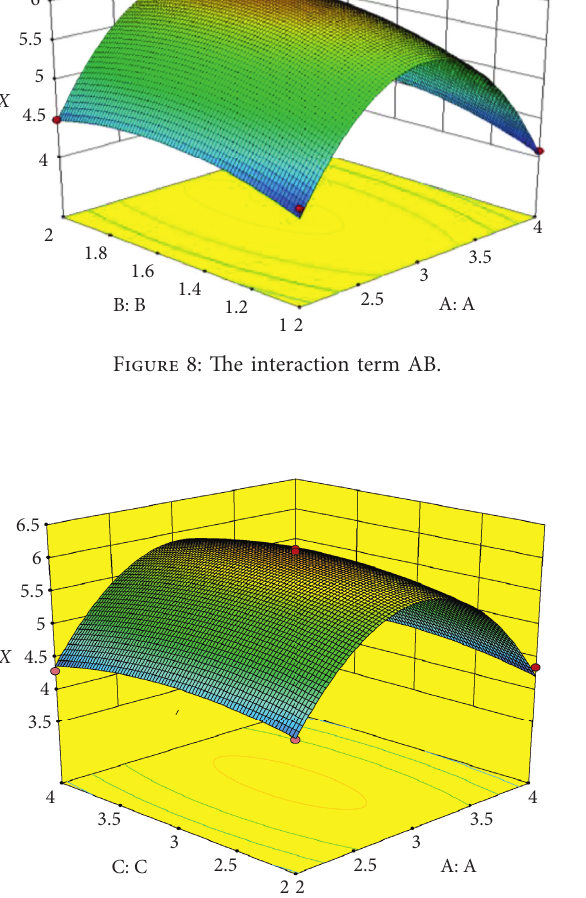
Figure 9: The interaction term